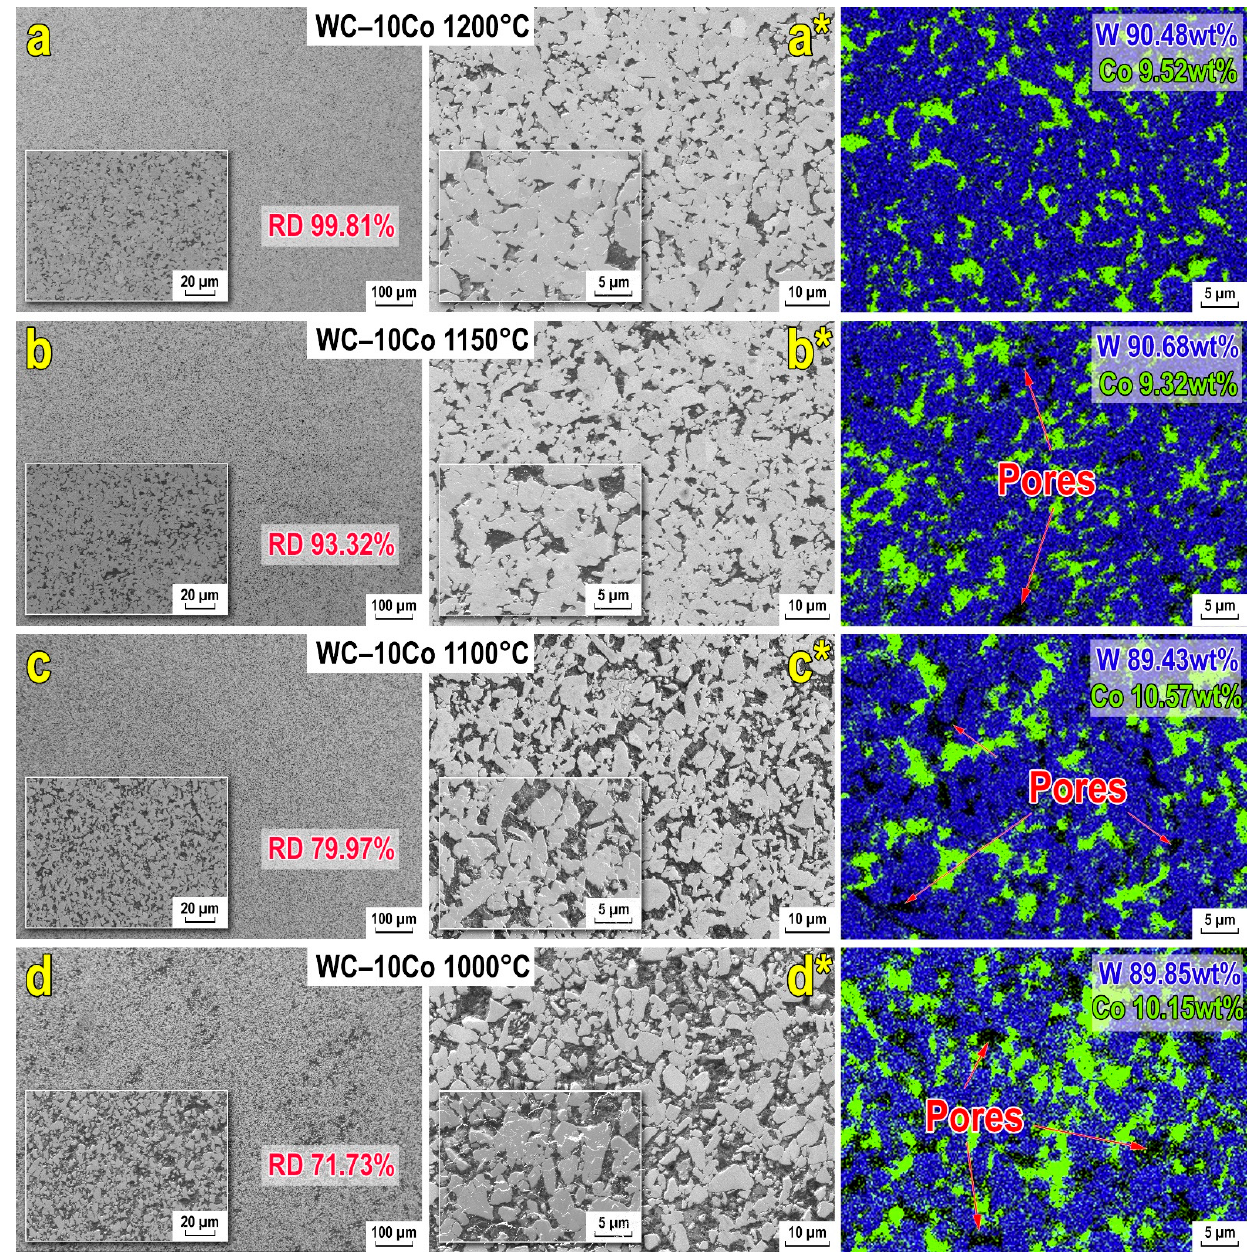
Figure 4. Microstructure and EDS maps of WC-10wt%Co hard alloys obtained via SPS-consolidation at various sintering temperatures: ( a , a *) 1200 °C; ( b , b *) 1100 °C; ( c , c *) 1150 °C; ( d , d *) 1000 °C (RD—relative density).